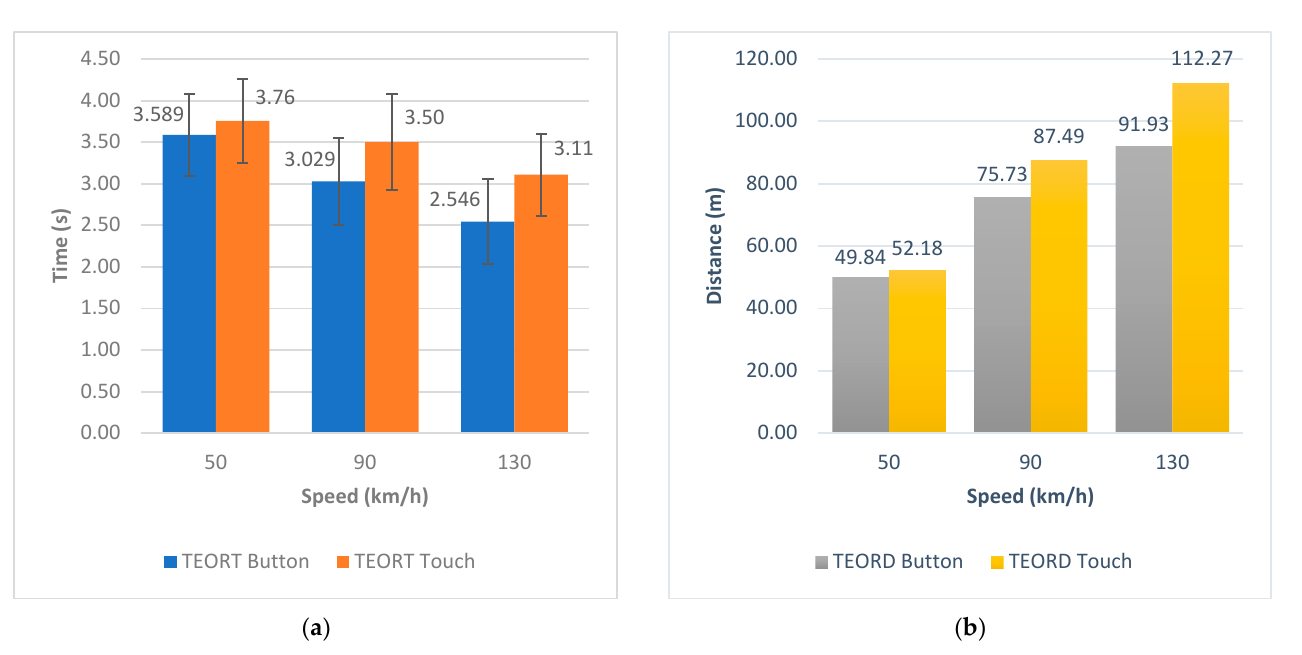
Figure 5. ( a ) TEORT and ( b ) TEORD values depending on speed and task type. Error bars denote CI (95%).